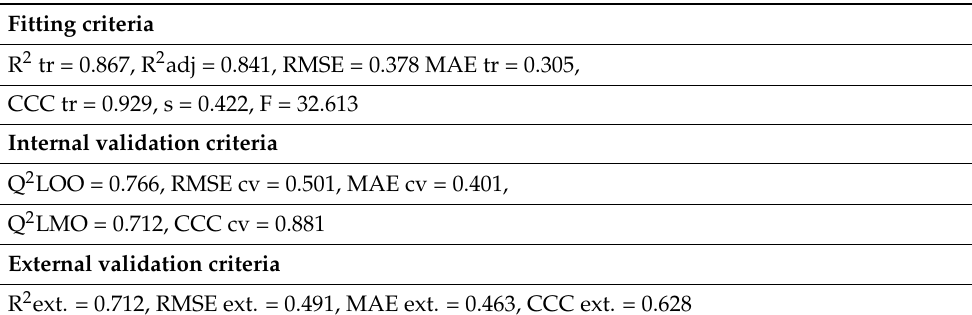
Figure 4. Plots of the experimental endpoint vs. predicted for ( A ) QPON1 by Equation (3) and ( B ) RPON1 by Equation (4), and the corresponding Williams plots for ( C ) QPON1 and ( D ) RPON1. Molecules in the training set are indicated by blue dots, while those in the validation set are indicated by orange dots. Table 4. Fitting, internal validation, and external validation criteria [67] for Q isozyme